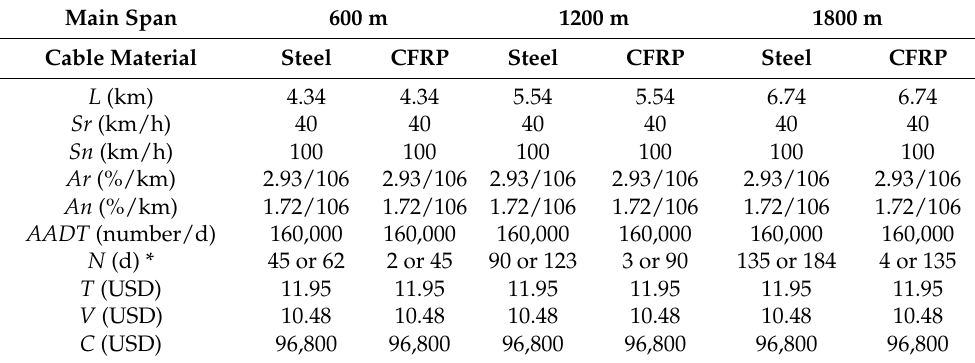
Table 9. Parameter values of user